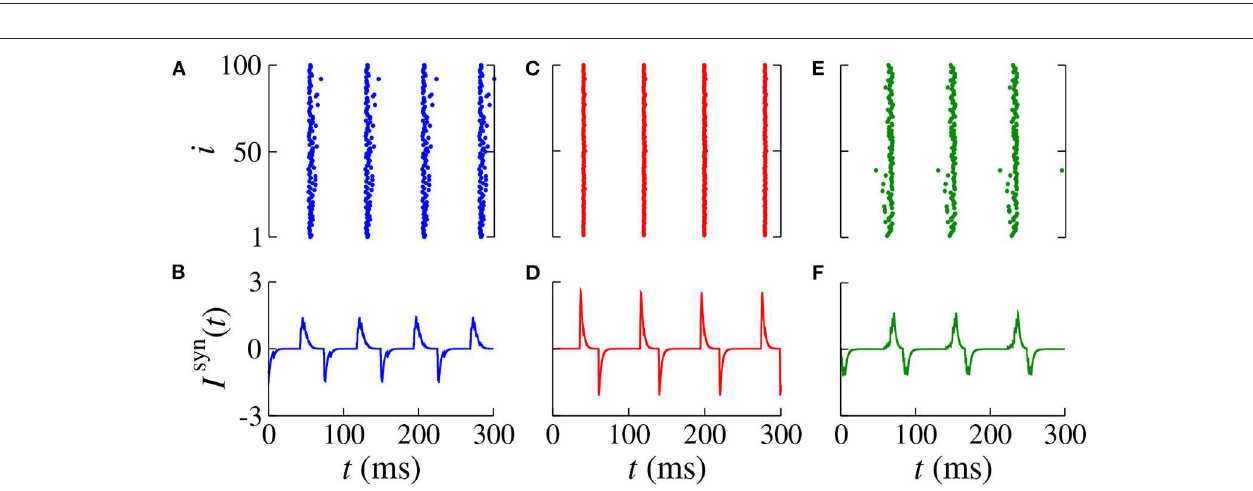
FIGURE 5 | Raster plot (top) and I syn ( t ) (bottom) for g exc = 0.2 nS, g = 6, and d inh = 30 ms for different values of d exc (blue squares in Figure 3 ). We consider (A,B) d exc = 65 ms (blue), (C,D) d exc = 75 ms (red), and (E,F) d exc = 85 ms (green).